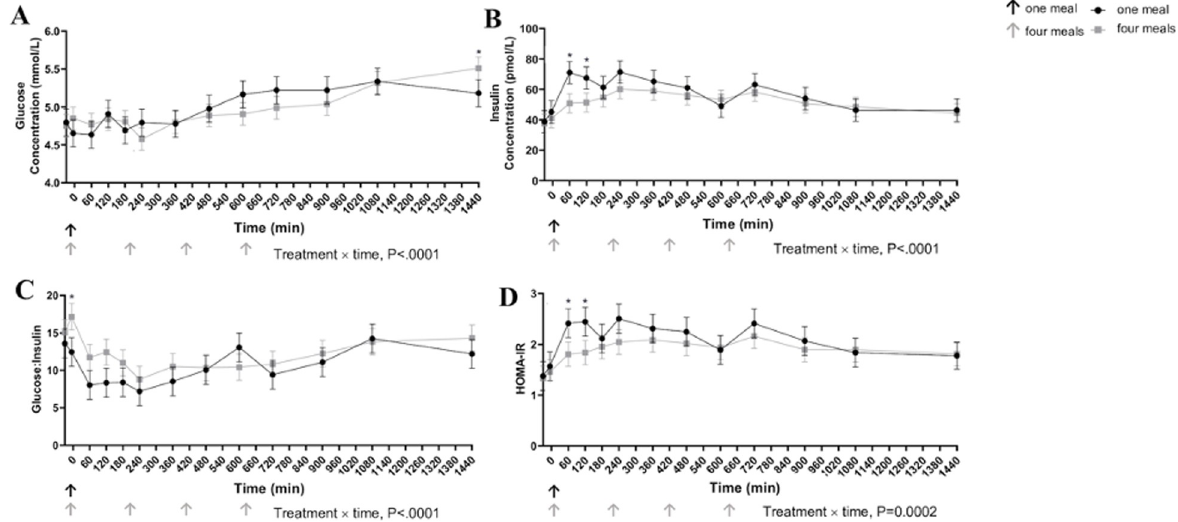
Fig 2. Whole glucose concentrations (mmol/L) (A), plasma insulin concentrations (pmol/L) (B), glucose to insulin ratio (C), and homeostatic model assessment of insulin resistance (HOMA-IR) (D) in cats eating a canned diet once (0800h) or four (0800h, 1130h, 1500h, and1830h) times daily over 24 hours (Eight cats were used and 4 of 8 repeated one of the two treatments, each mean represents 11 experimental periods). Values are expressed as LSM ± SEM. � = P < 0.05.